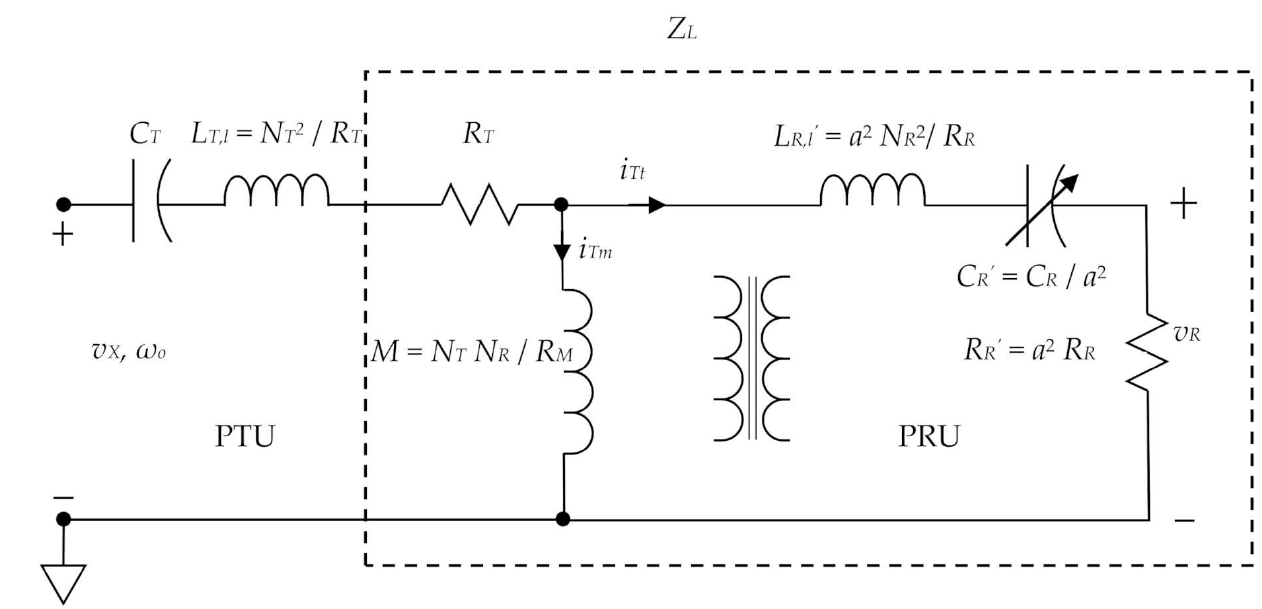
Figure 1. Wireless power transfer equivalent